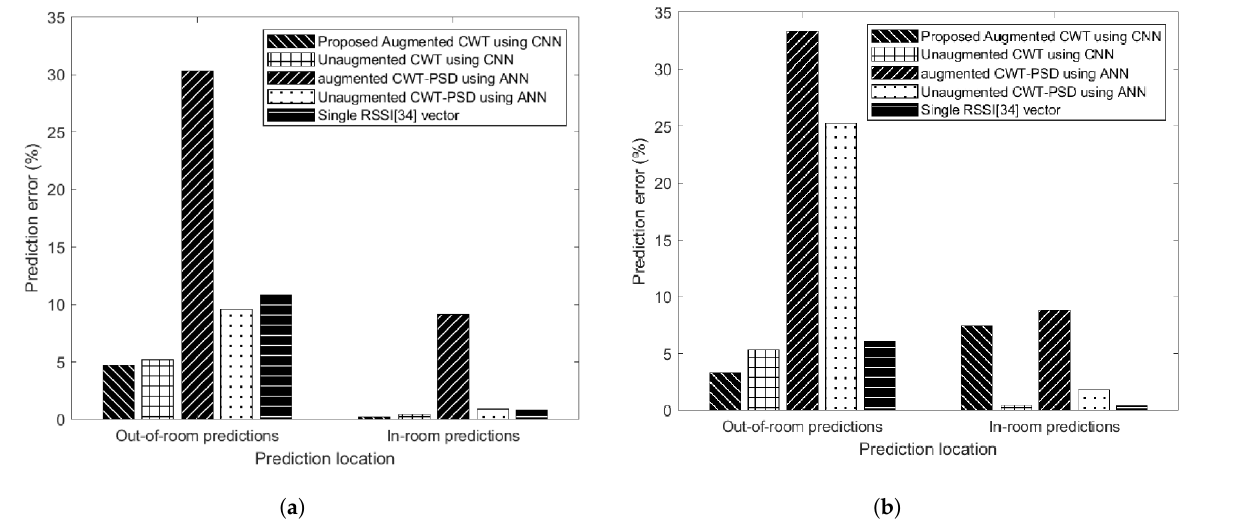
Figure 10. ( a ) Morse and ( b ) Morlet-based prediction error results